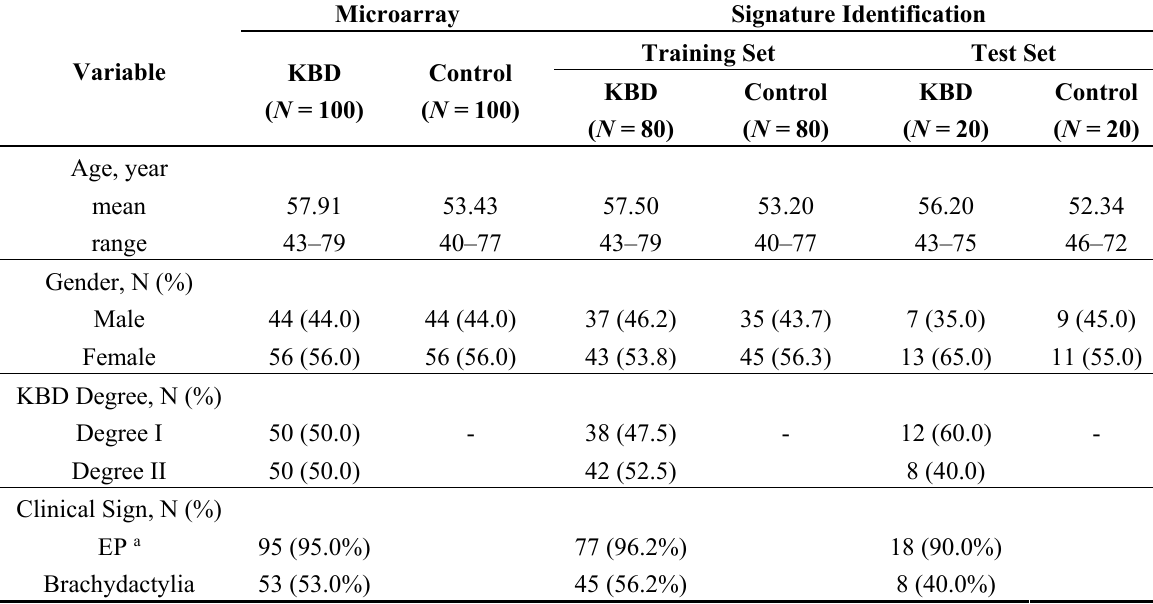
Table 3. Characteristics of the patients with KBD and the